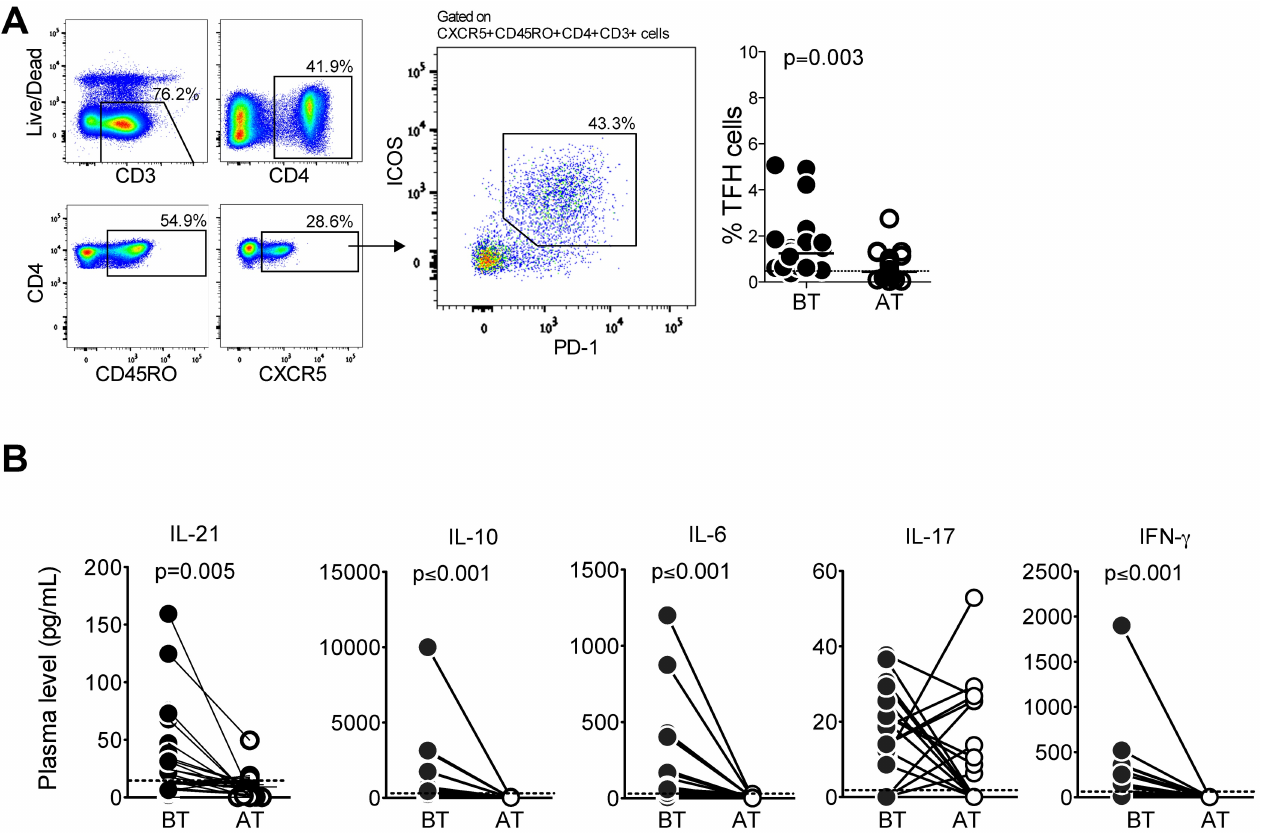
Fig 2. Plasmodium vivax -infected patients display higher frequency of circulating Tfh cells and increased levels of Tfh cells like cytokines. PBMC and plasma from P . vivax -infectedpatients were analyzedex vivo (n = 24) duringacute malaria episode(BT) and 30–45 days after treatment (AT). A . Gating strategy for the analysisof Tfh cells basedon the simultaneous expressionof PD- 1 + ICOS + CXCR5 + CD45RO + CD4 + CD3 + within live PBMC (density plots, counter clockwise) and scattered plots (right panel)showingthe distribution of the percentageof Tfh cells in P . vivax -infected patients before (BT) and after treatment (AT). B . IL-21, IL-6, IL-10, IL-17 and IFN- γ were measured in plasma of P . vivax -infected patients before (filled circles) and after (open circles) treatment. Lines represent median values of the given measurement in each group. Dotted lines represent healthydonors. p values are depicted in the